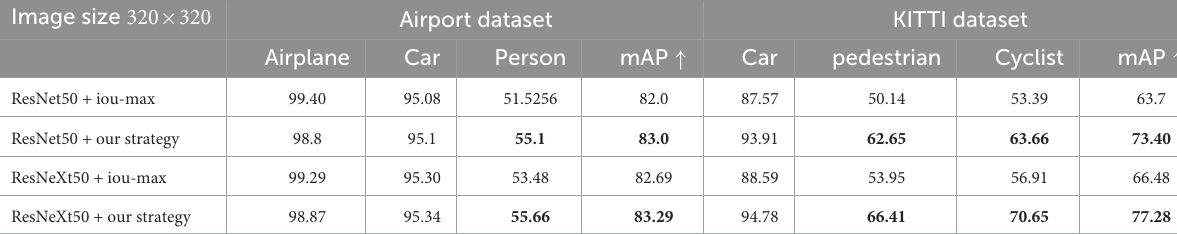
TABLE 5 Detection results on KITTI dataset and Airport dataset using two different matching strategies for